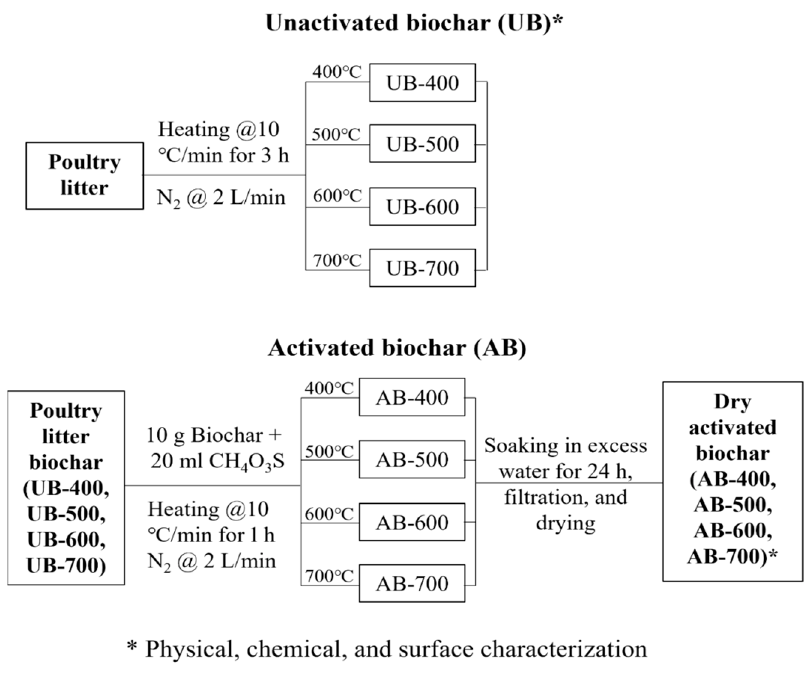
Figure 1. Production process of unactivated biochar (UB) and activated biochar (AB) at temperatures between 400–700 °C from poultry litter for their characterization.